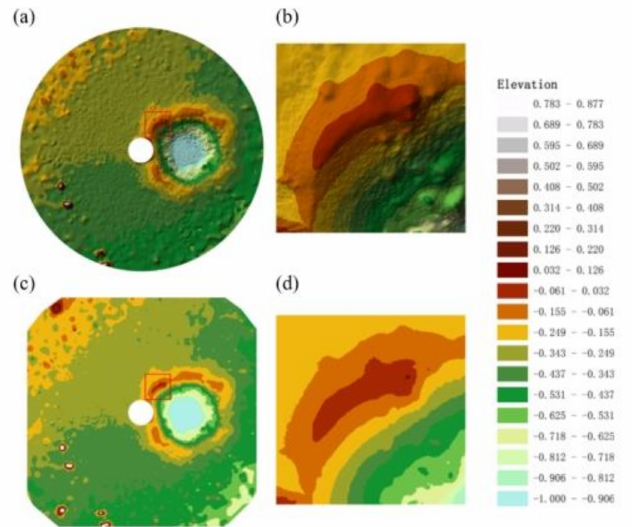
Figure 8. ( a ) cvrDEM, ( b ) enlarged view of the area outlined by a rectangle in ( a ), ( c ) grid DEM, and ( d ) enlarged view of the area outlined in ( c